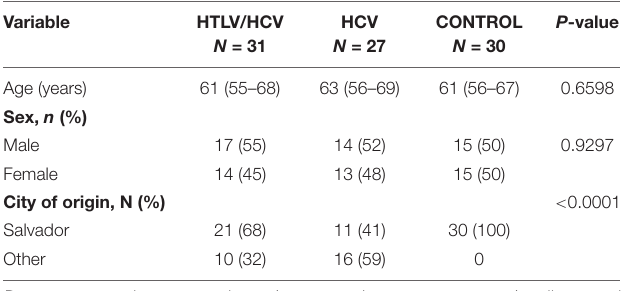
TABLE 1 | Demographic characteristics of HTLV/ HCV-, HCV-infected patients and controls. Variable